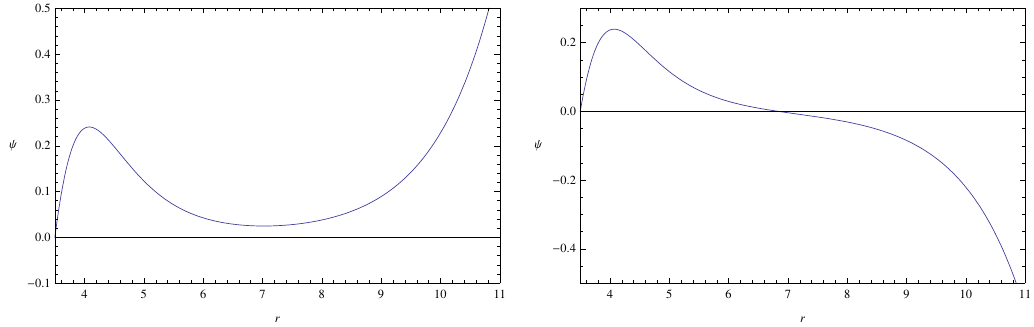
Figure 1 . (Color online) We plot the scalar (cid:12)eld ( r ) as a function of the coordinate r with mr s = 3 : 5 and mM = 1 : 5. The left panel corresponds to m 2 (cid:17) = 132 and the right panel is with m 2 (cid:17) =